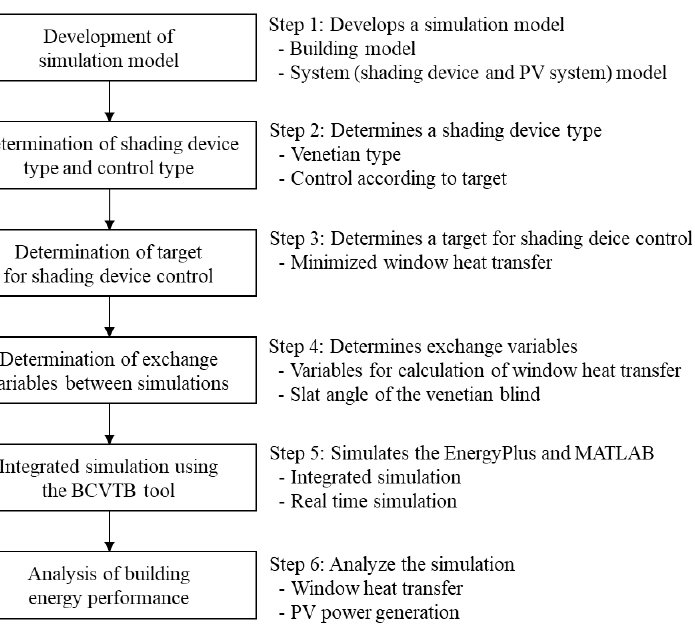
Figure 1. Diagram of the overall research